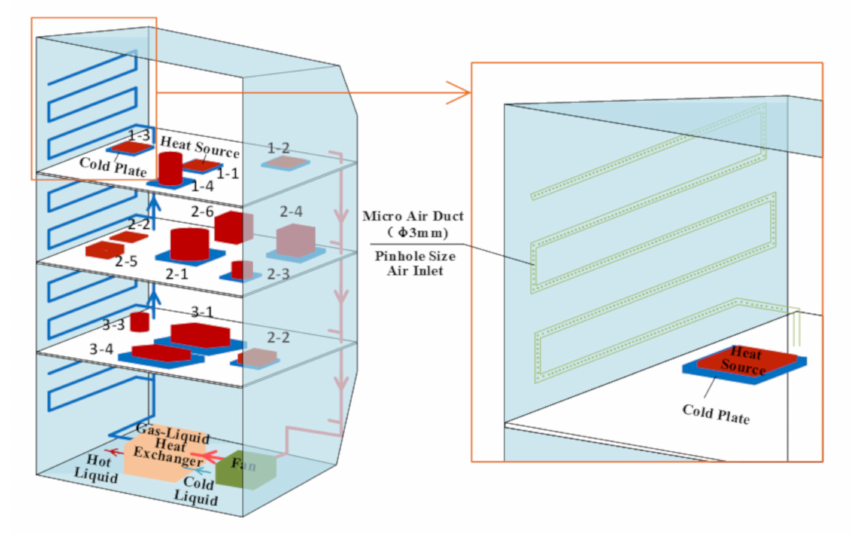
Figure 3. Diagram of new air cooling